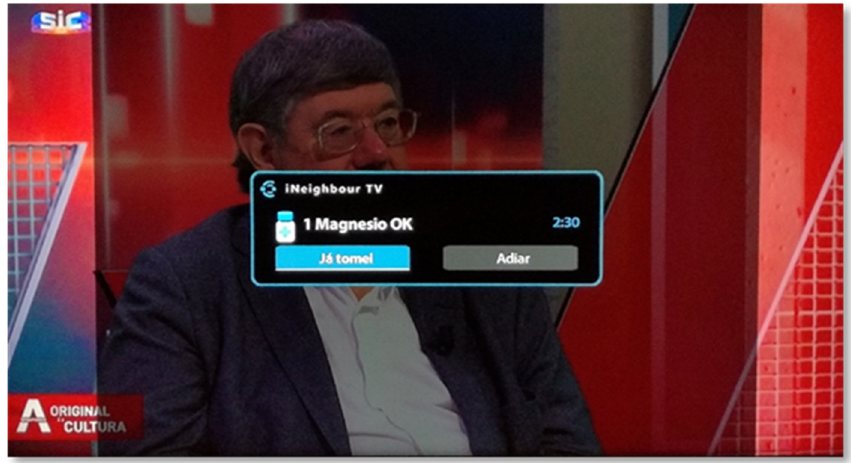
Figure 6. Reminder to take medication.